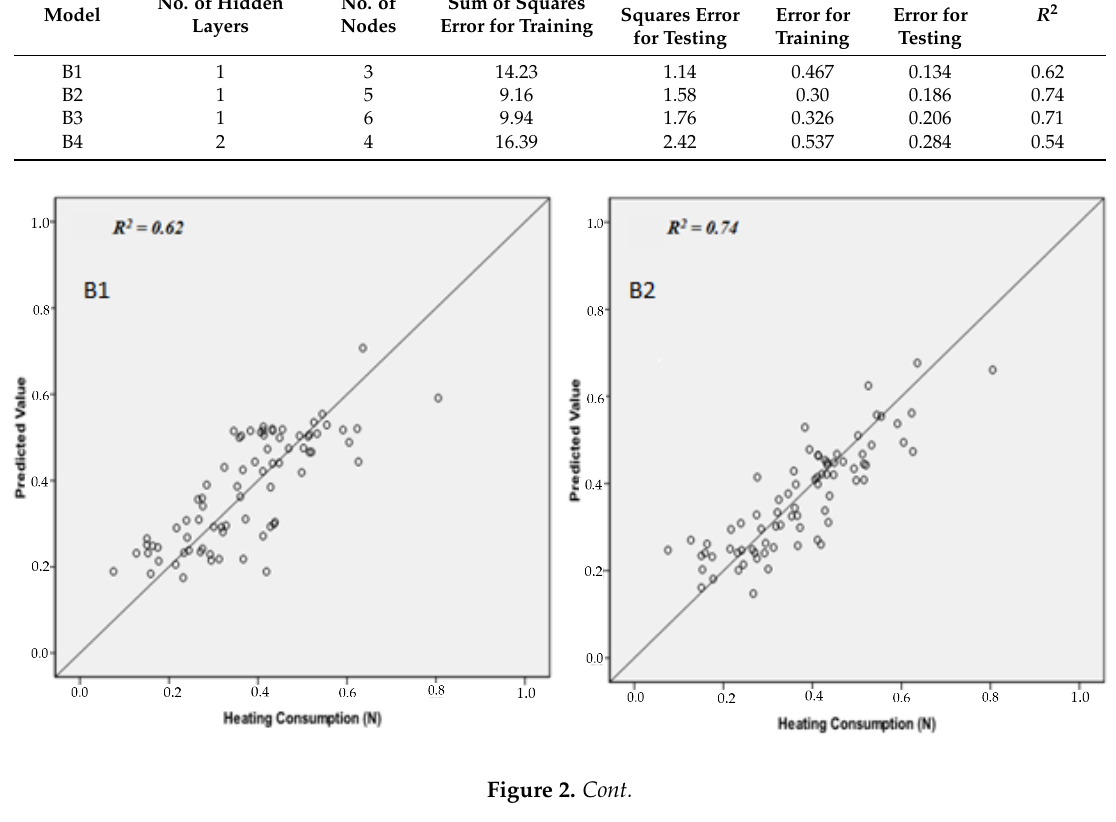
Table 3. Configurations used for the determination of the optimal ANN architecture. Model